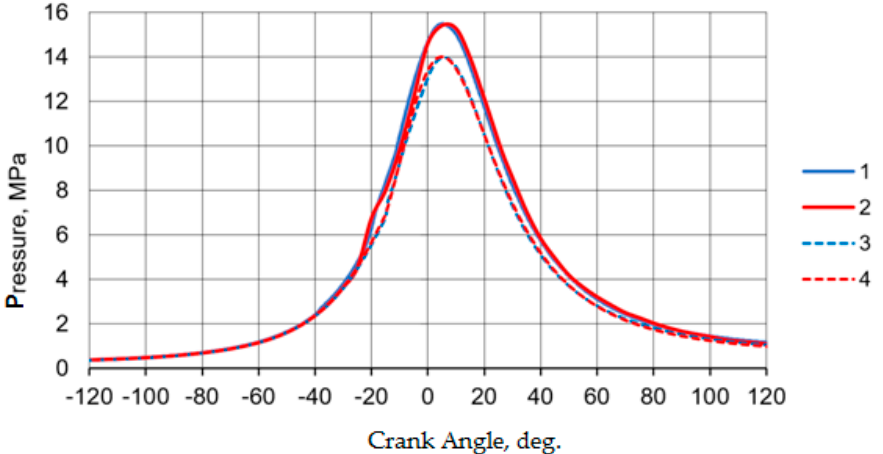
Figure 3. Comparison of experimental and calculated indicator diagrams of gas pressure in the engine combustion chamber: 1—experiment with fuel and water injection; 2—calculation with fuel and water injection; 3—experiment without fuel and water injection; 4—calculation without fuel and water injection. (Source: Authors).